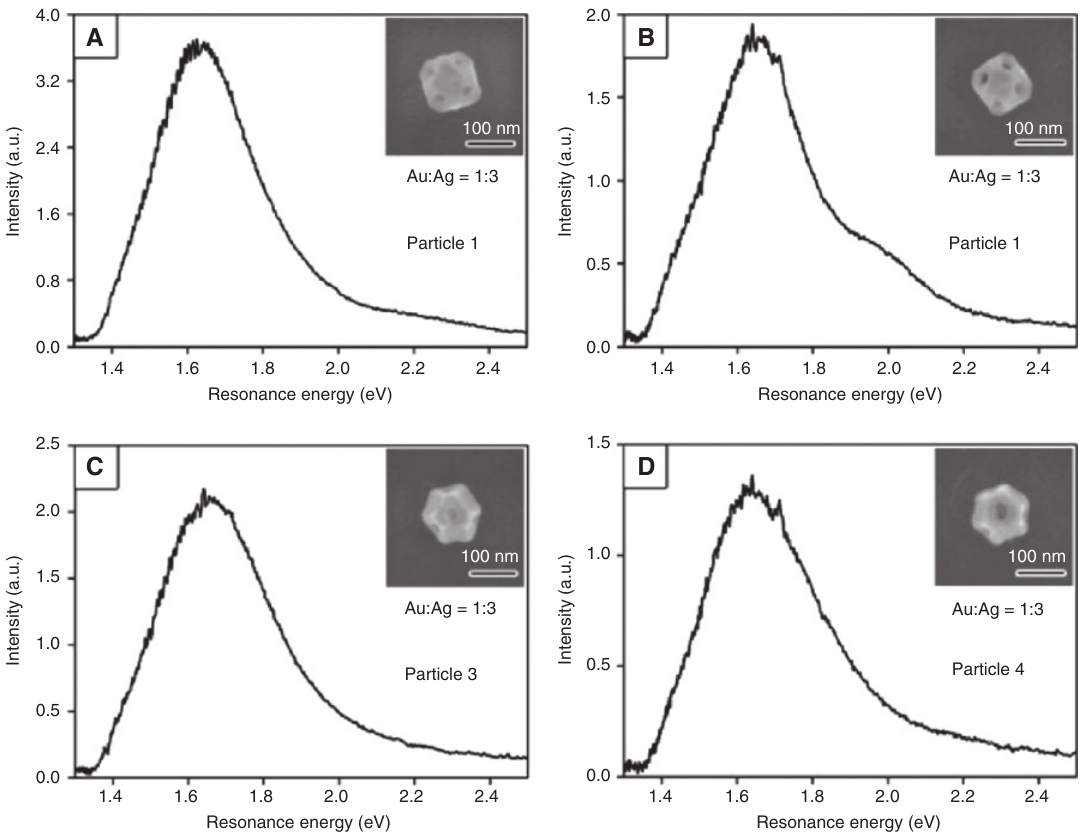
Figure 5: Correlated Rayleigh scattering spectra and SEM images of 4 different AuAg nanocages. AuAg nanocages in (A) and (B) are oriented as their [100] facets are in contact with the substrate, whereas [111] facets are in contact with the substrate for the AuAg nanocages in (C) and (D) (reproduced with permission from Ref. [125],copyright 2007 American Chemical